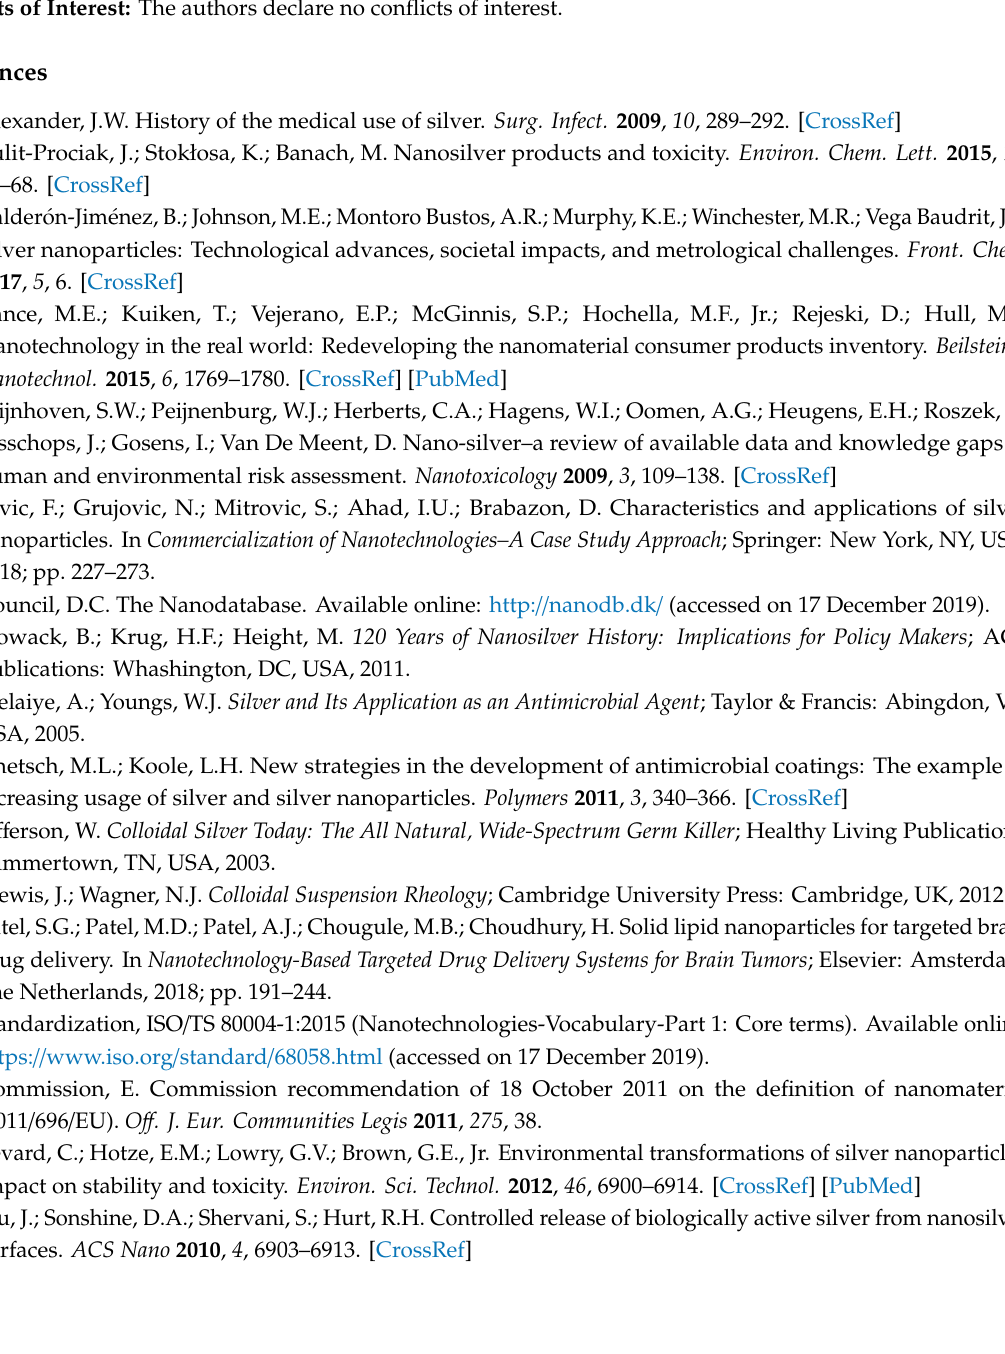
Figure S1. Intensity size distribution of batch 2 of product 8; Table S1. P -values of one-sample T-tests to test if the measured concentration was significantly di ff erent from the concentration on the label; Table S2. P -values